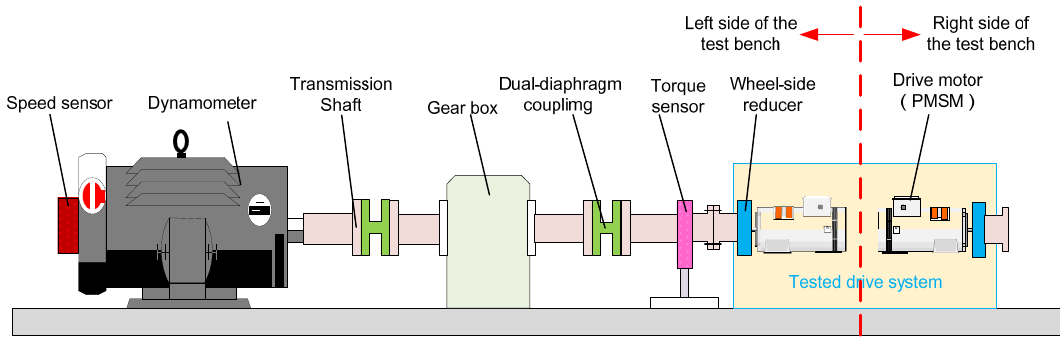
Figure 3. Schematic diagram of the DDTV test bench (The left side is only displayed due to symmetrical arrangement of the test bench).